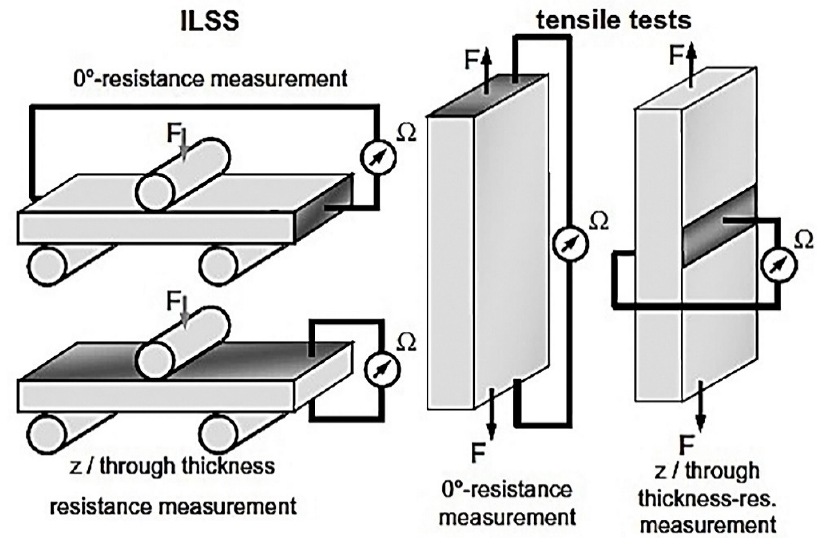
Figure 8. Resistance and tensile test measurement setup [55].